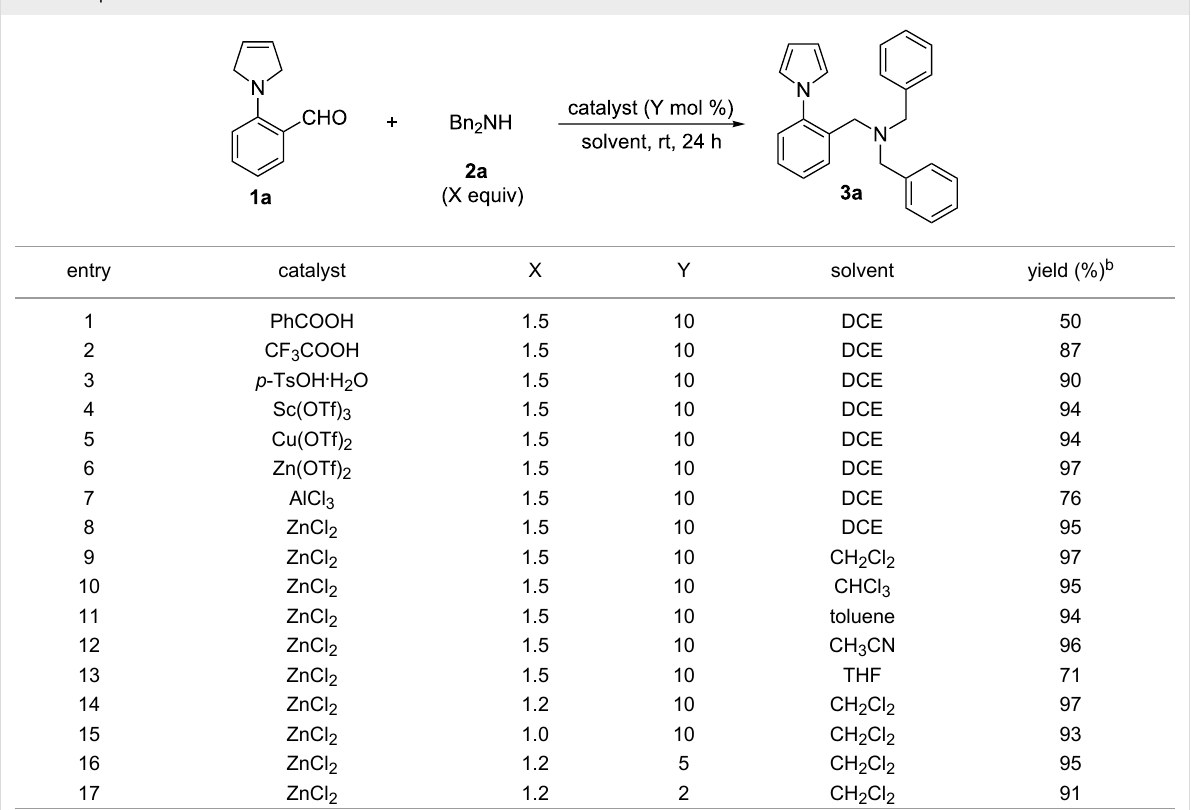
Table 1: Optimization of the redox-neutral amination reaction. a